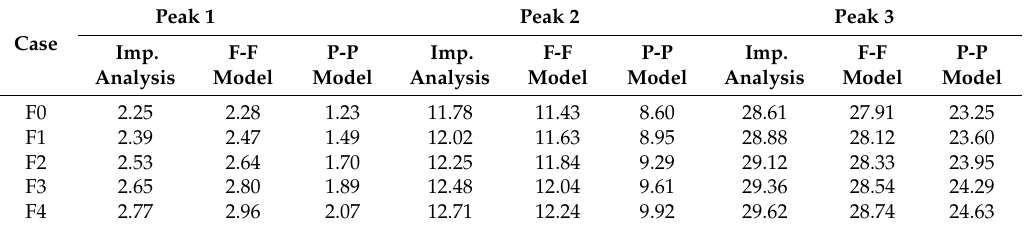
Figure 11. Natural frequencies of wearable PZT interface: numerical impedance analysis vs. analytical Table 5. Natural frequencies (kHz) of the wearable PZT interface under tension force changes.